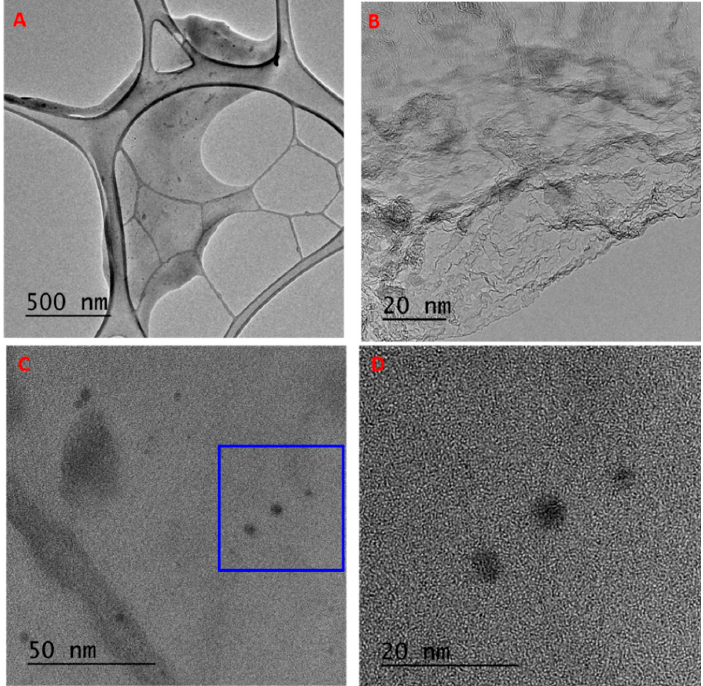
Figure 5. Representative high-resolution transmission electron microscopy (HRTEM) images of PVA@rGO-Ag1 ( A – D ). Area visualized in D is highlighted in C by the blue rectangle. PVA@rGO-Ag1 ( A – D ). Area visualized in ( D ) is highlighted in ( C ) by the blue rectangle.